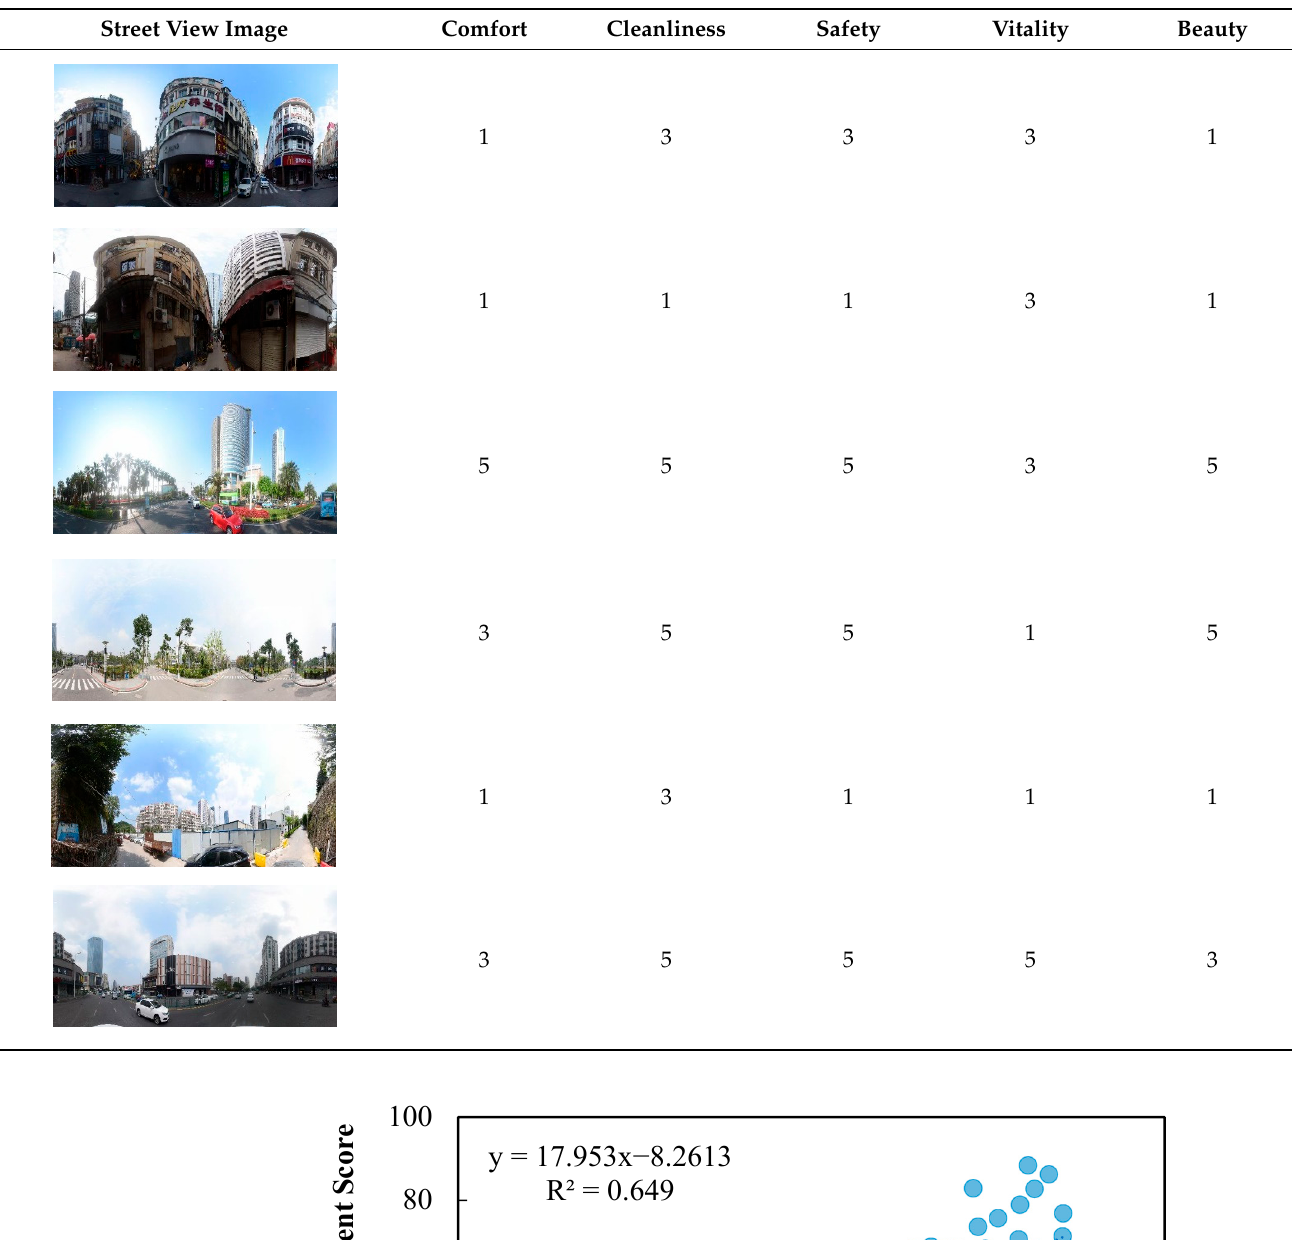
Table 5. Evaluation criteria.